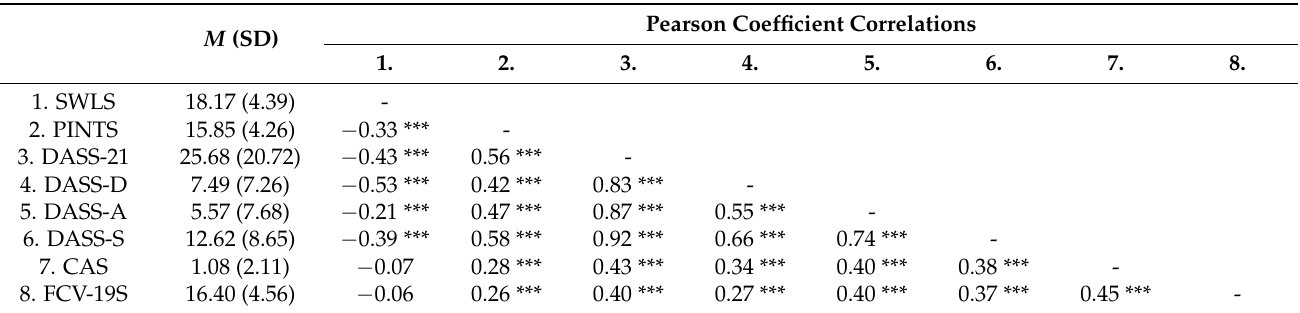
Table 2. Mean, standard deviation, and Pearson coefficient correlations between SWLS, PINTS, DASS and its subscales, CAS and FCV-19S (N =